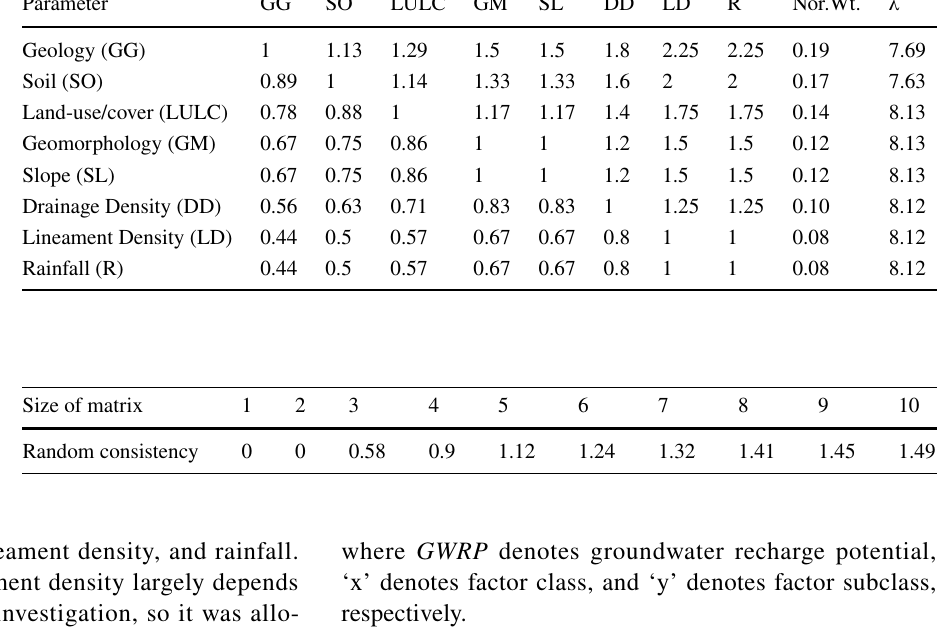
Table 6 Standardized pairwise comparison matrix showing values of normal weight and λ